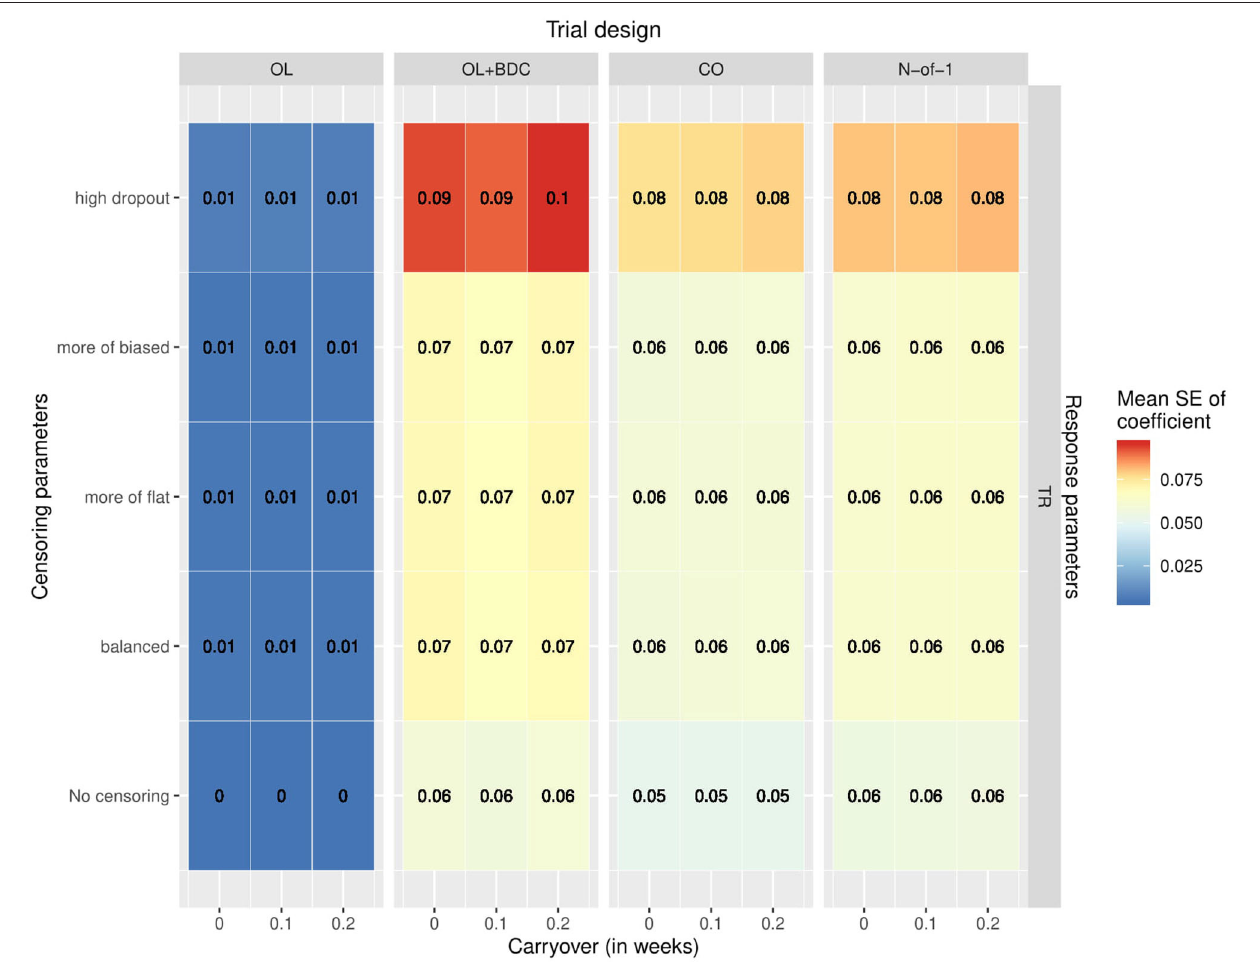
FIGURE 6 | Mean standard error in the coefficient for the interaction term used for hypothesis testing across simulated replicates, as a function of trial design, response parameters, carryover, and censoring parameters. OL = open label, OL + BDC = open label followed by blinded discontinuation, CO = cross over, N-of-1 = proposed N-of-1 trial